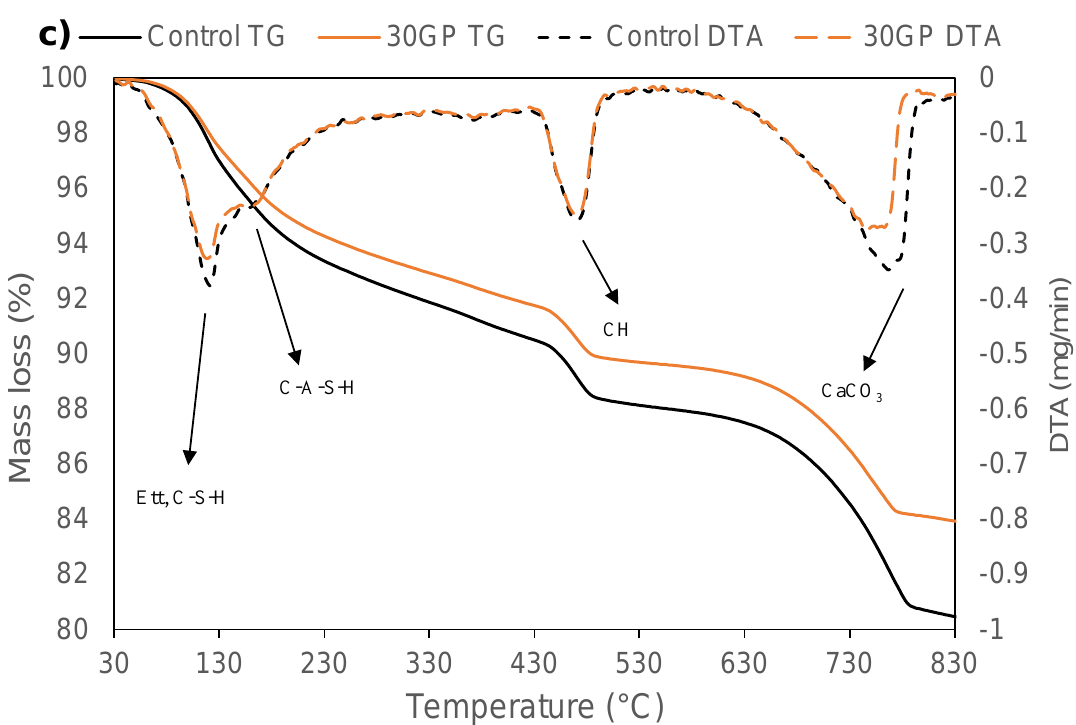
Figure 3. TG-DTA curves of CEM I and 30GP pastes at 7 ( a ), 14 ( b ) and 28 ( c ) days of curing.